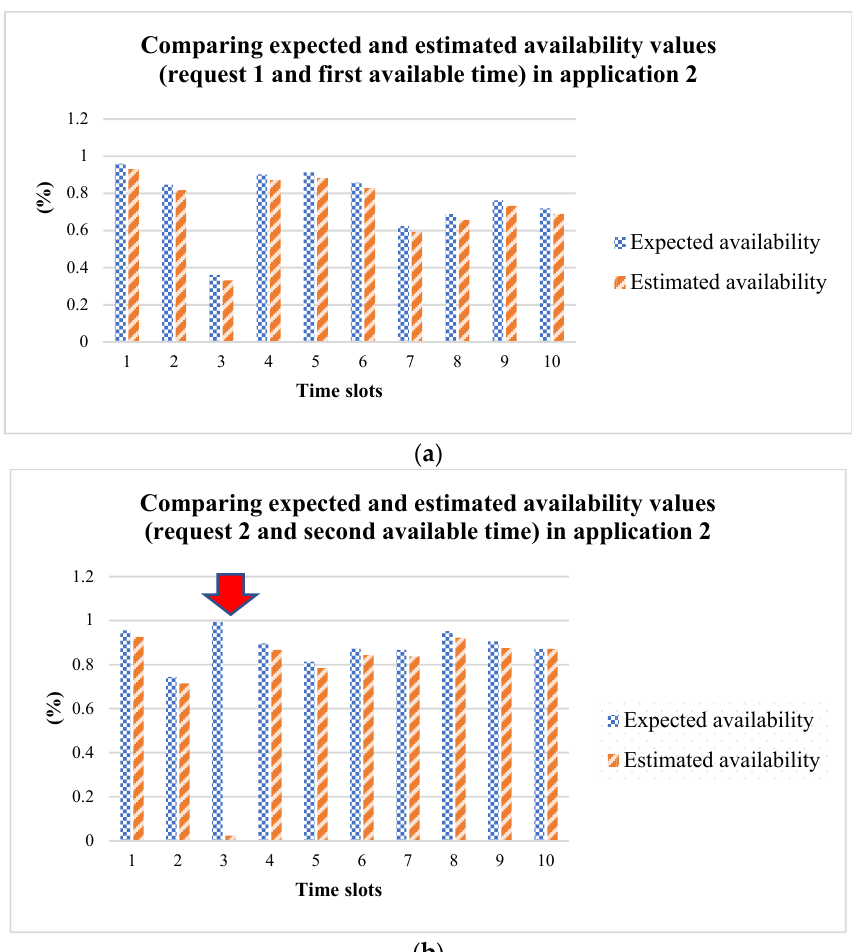
Figure 11. Comparing the expected and estimated availability values in application 2: ( a ) Comparing the expected and estimated availability values without losing a correct decision; ( b ) Comparing the expected and estimated availability values with losing a correct decision (Red colored pointer demonstrates the incorrect decision-making).